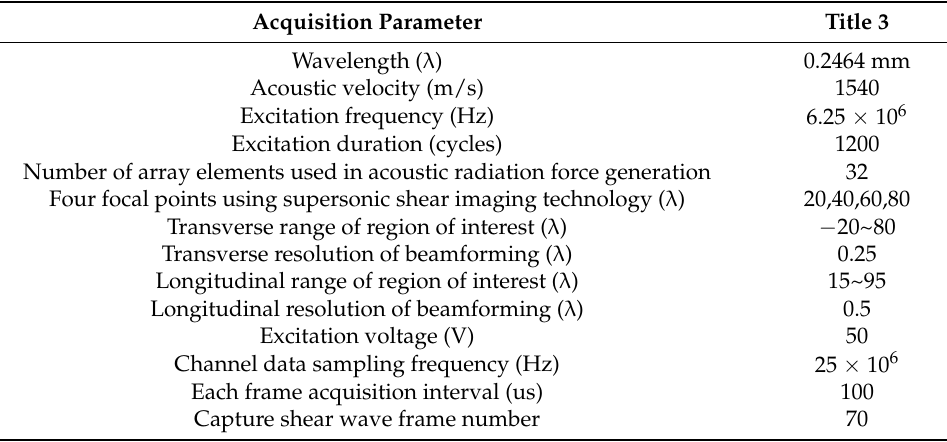
Table 1. Multi-focus excitation acquisition